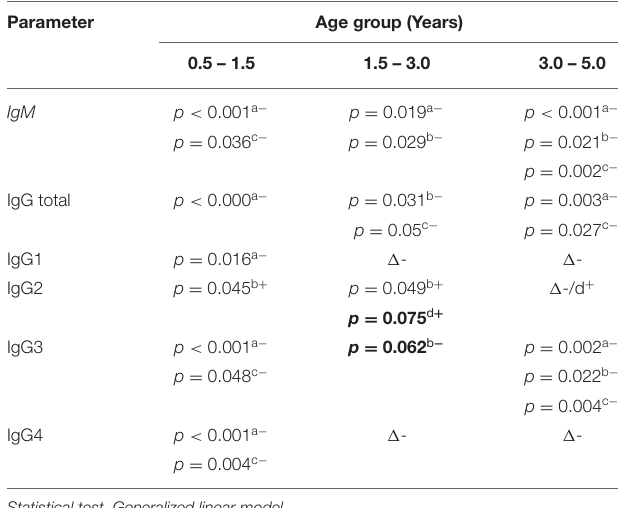
TABLE 3 | Variation in levels of IgM, IgG total, and IgG subclasses due to age in zinc-deficient children compared to the healthy reference group.